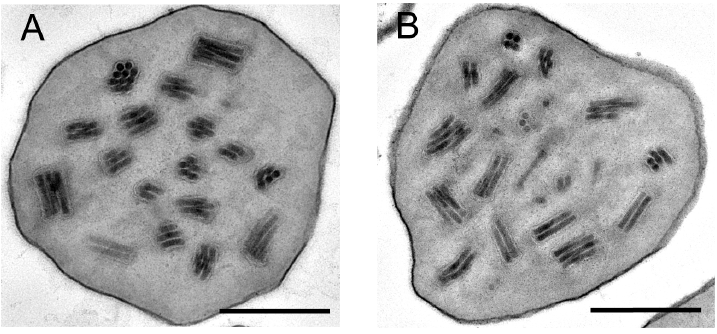
Figure 4. TEM micrograph of sectioned OBs of SfHub ‐ A ( A ) and SfHub ‐ E ( B ). Scale bars = 0.5 μ m.